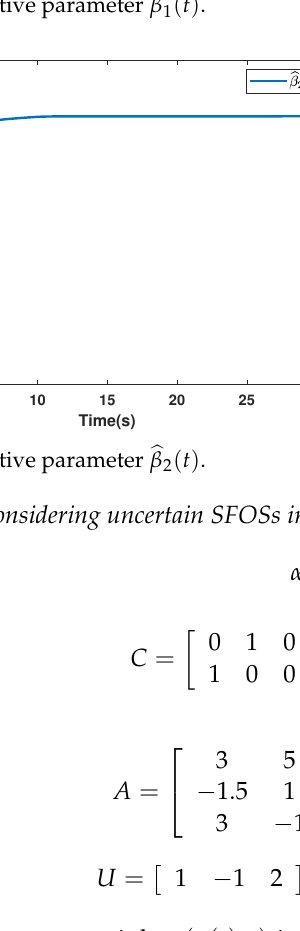
Figure 6. Adaptive parameter (cid:98) β 1 ( t ) .